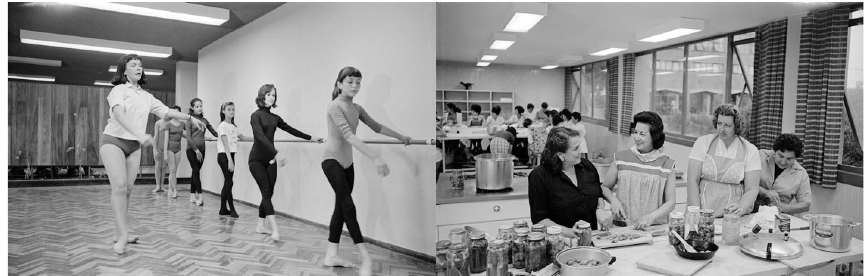
Figure 11. Pictures of groups of women learning ballet and cooking and baking at the Casa de la Asegurada of the Unidad Independencia housing complex. Source: from left to right: Teacher and dancers during ballet class (MID 77_20140827-134500:378993) and Women prepare food in a cooking workshop (MID 77_20140827-134500:379331), López; Colección Nacho López—Fototeca Nacional; Instituto Nacional de Antropología e Historia, Mediateca INAH; 1960, 1965.